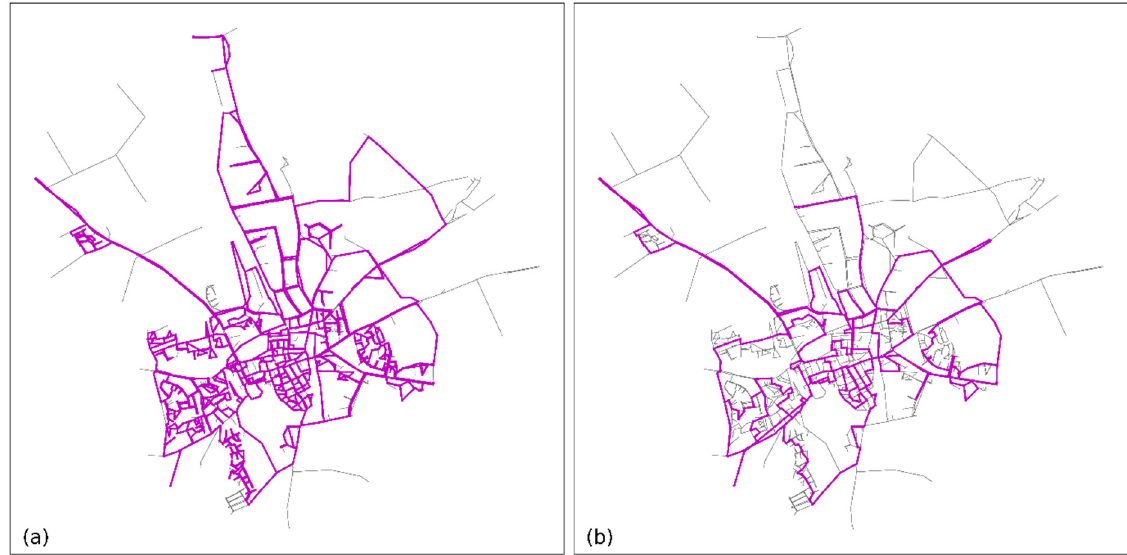
Figure 4. Layout of the secondary (magenta) and tertiary (grey) pipes in the current design ( a ) and the optimized design ( b ). Compared to the current design, the optimized design shows a clearer secondary structure and a greater number of branched tertiary pipes.